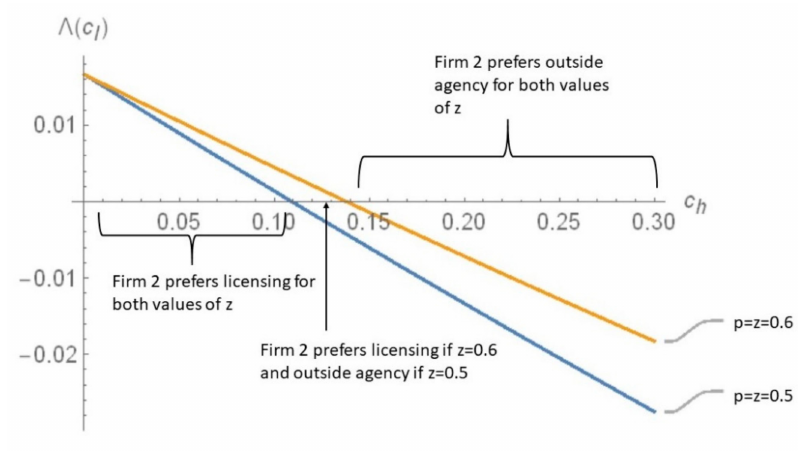
Figure 2. Outside agency vs. licensing for Cases (iii) and